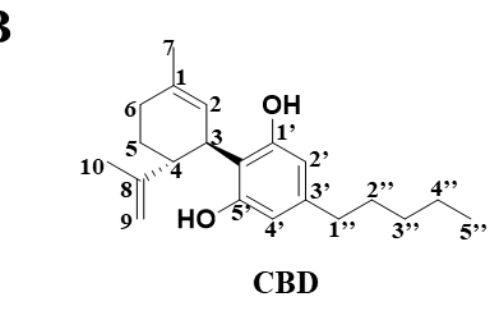
Figure 1. The chemical structure of compounds in ( A ) THC and ( B ) Figure 1. T he chemical structure of compounds in ( A ) THC and ( B ) CBD.